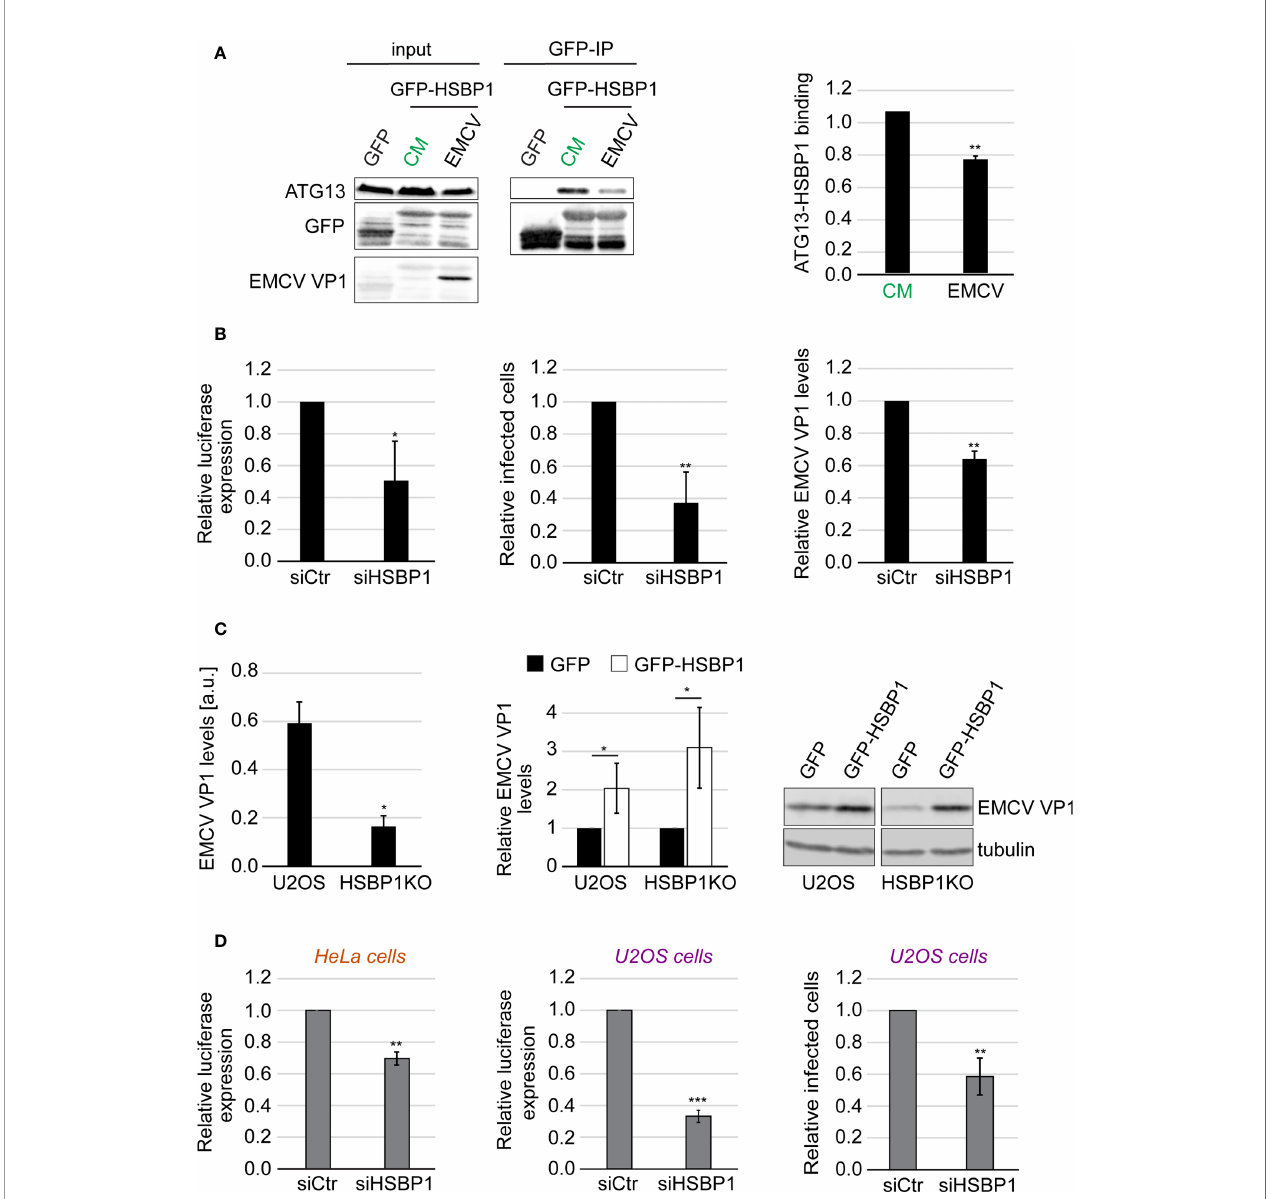
FIGURE 3 | HSBP1 promotes EMCV and CVB3 replication. (A) U2OS cells were transfected with a plasmid carrying GFP or GFP-HSBP1 for 24 h and then kept in CM or were infected with EMCV for 6 h. Cells were then lysed and immunoprecipitated using GFP ‐ trap beads. Input lysates and Co-IP were examined by WB using antibodies against ATG13, GFP and EMCV VP1. Signal intensities were quanti fi ed and the of ATG13/GFP-HSBP1 ratios in the Co-IP were determined before to be normalized to that of the CM samples. Error bars represent SDs of 4 independent experiments. (B) U2OS cells were transfected with either siCtr or siHSBP1 for 48 h before being infected with EMCV or a luciferase-expressing EMCV strain (left panel) for 6 h. EMCV replication was quanti fi ed by luciferase expression (left panel), EMCV VP1-positive cells by IF (middle panel) and EMCV VP1 levels by WB (right panel). Error bars represent SDs of 3 (WB, right panel) or 4 independent experiments (luciferase and IF, left and middle panels). (C) U2OS and HSBP1KO cells were transfected with a plasmid expressing either GFP-HSBP1 or GFP for 24 h before being infected with EMCV for 6 h. Cells were then lysed and WB membranes probed with anti-EMCV VP1 and anti-tubulin antibodies. Tubulin was used as the loading control. Signal intensities were quanti fi ed and normalized to tubulin. EMCV VP1 levels in U2OS and HSBP1KO cells expressing GFP are compared in the left panel. EMCV VP1 levels in U2OS or HSBP1KO cells carrying GFP-HSBP1 were expressed relative to those in the same cells but carrying GFP (right panel). Error bars represent SDs of 4 independent experiments. (D) U2OS or HeLa cells were transfected with either siCtr or siHSBP1 for 48 h, before being infected with CVB3 (right panel) or a luciferase-expressing CVB3 strain (left and middle panels) for 6 h. CVB3 replication in HeLa cells was measured by luciferase expression (left panel) and in U2OS cells by either assessing luciferase expression (middle panel) or the percentage of CVB3 VP1-positive cells (right panel). Error bars represent SDs of 3 (HeLa cells) or 4 (U2OS cells) independent experiments. The statistical signi fi cances were calculated to the controls. The symbols *, ** and *** indicate signi fi cant differences of p < 0.05, p < 0.01 and p < 0.001,